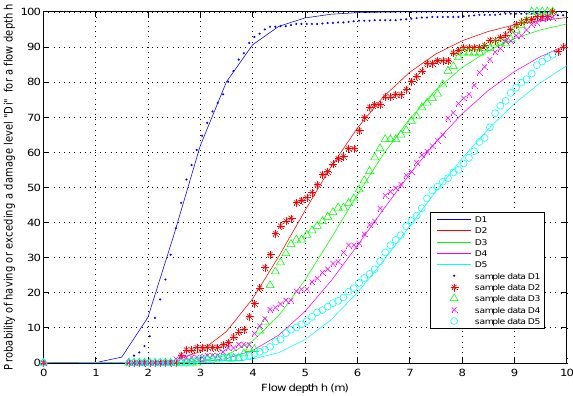
Fig. 3. Comparison between flow depths estimated by Kriging interpolation (grid size 15m) and Natural Neighbour interpolation (grid size 80m) vs observed flow depths by three teams. The RMSE obtained with the ordinary Kriging was 40cm while the RMSE obtained with Natural Neighbour was 1.30m